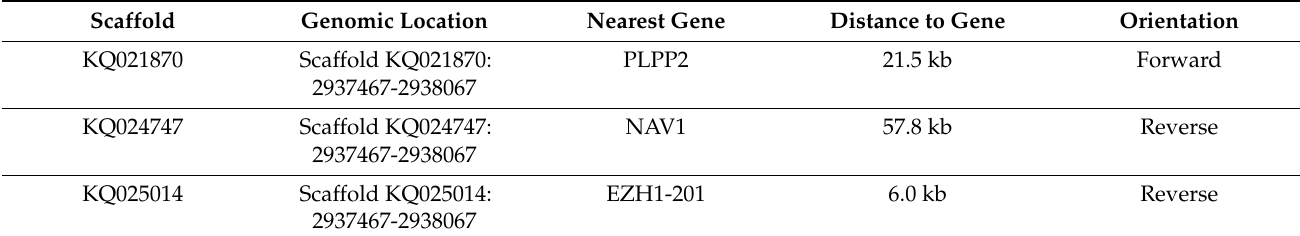
Table 1. PSRV1 integration sites in P. coquereli preliminary genome sequence assembly. Scaffold Genomic Location Nearest